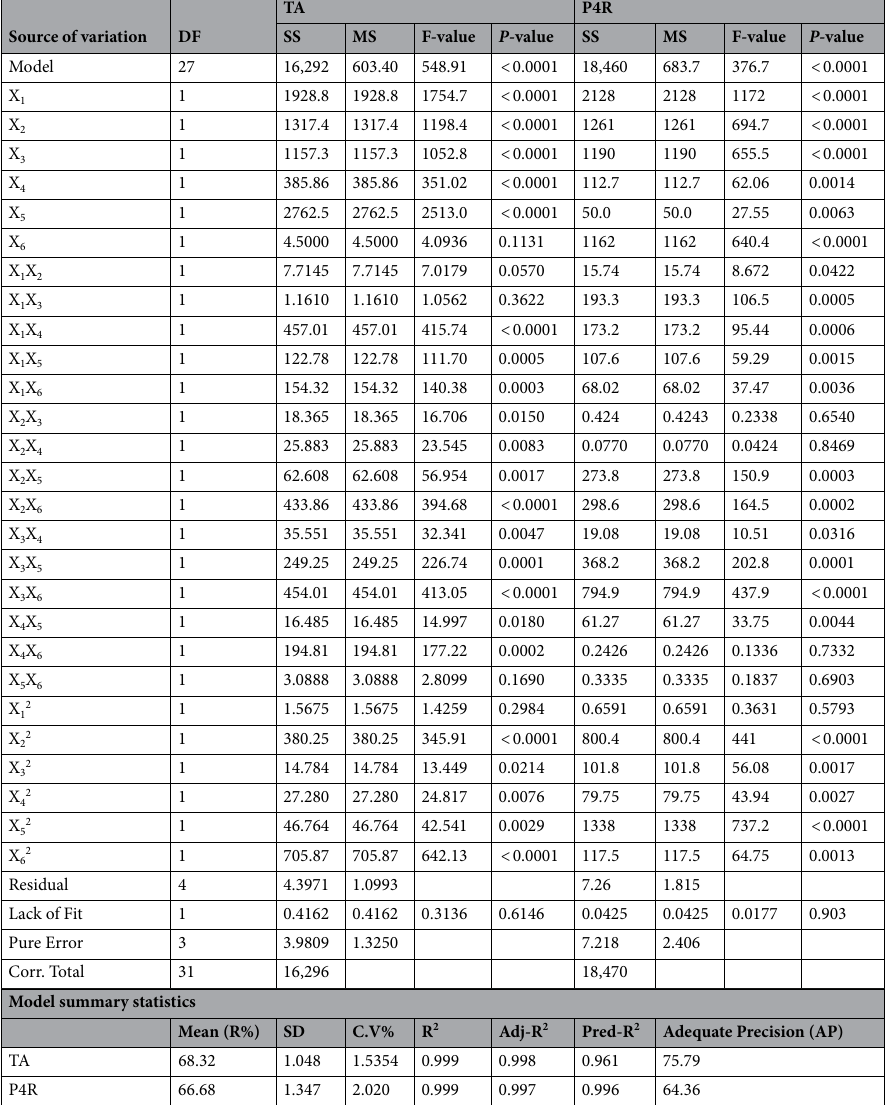
Table 3. ANOVA of the regression model for the prediction of dyes removal yield. DF: Degrees of Freedom; SS: Sum of Squares; MS: Mean Square; SD: Standard Deviation; RSD: Relative Standard Deviation; C.V: Coefficient of variation; R 2 :R-squared; Adj-R 2 : Adjusted-R 2 ; Pred-R 2 : Predicted